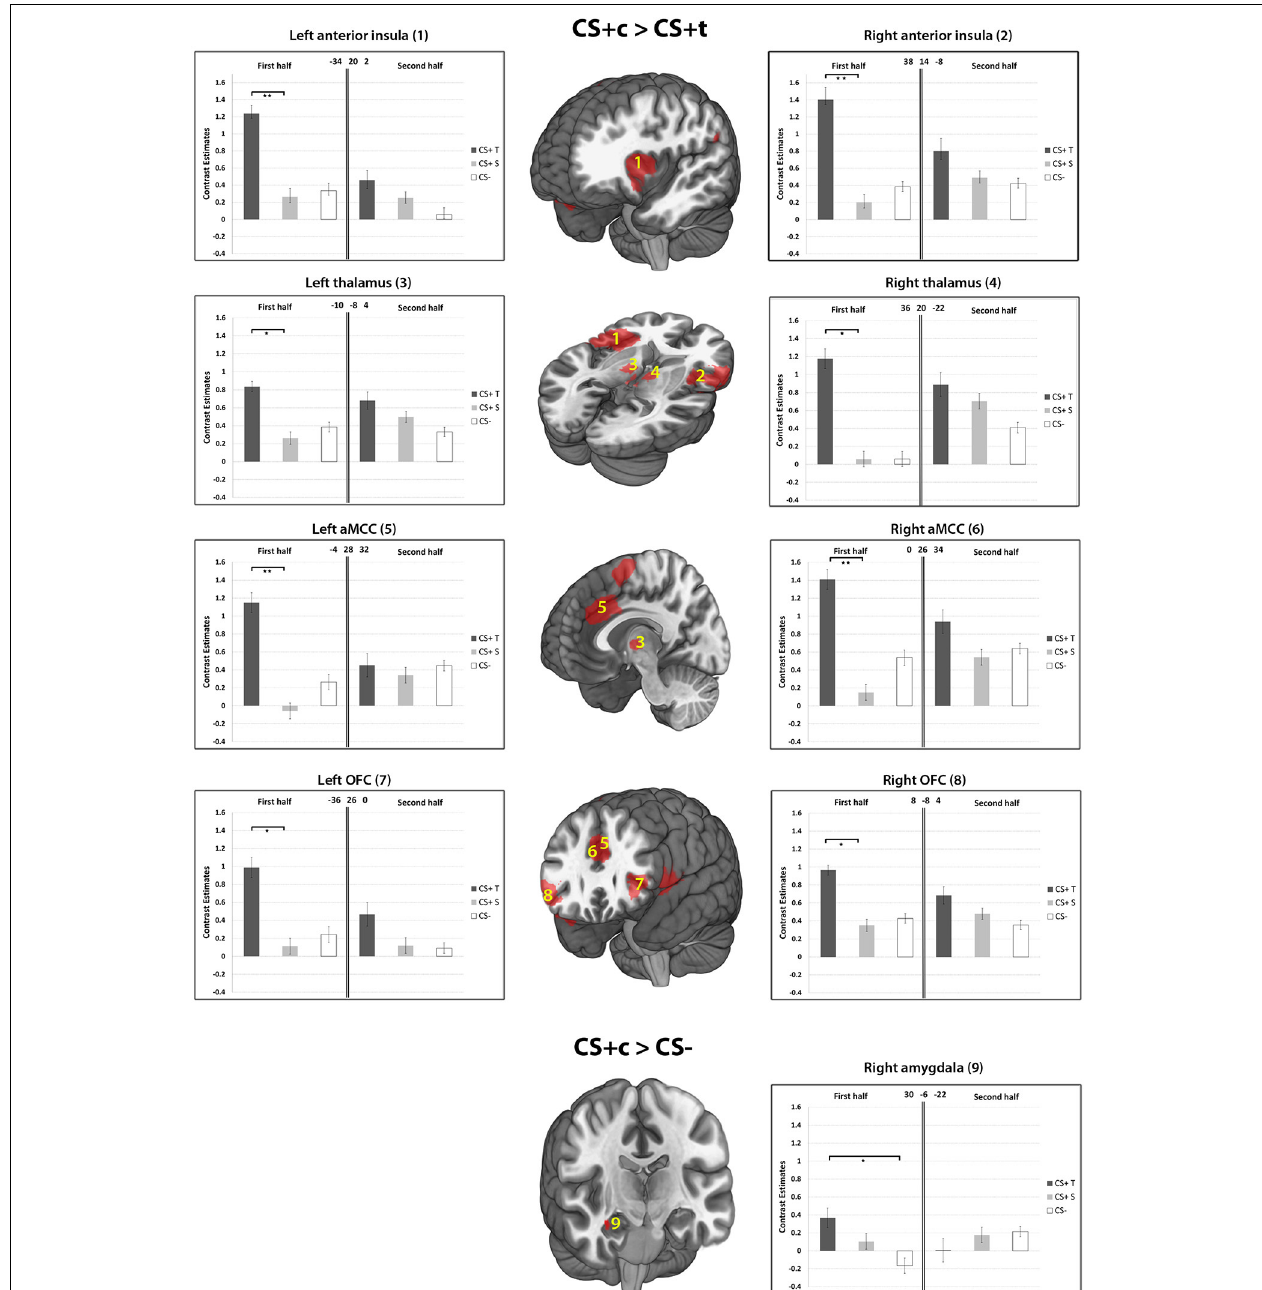
FIGURE 7 | Results of the contrasts CS + c > CS + t, and CS + c > CS − within ROIs 1–9. Whole-brain SPM activations maps are shown with a statistical threshold of p < 0 . 001, uncorrected, voxel